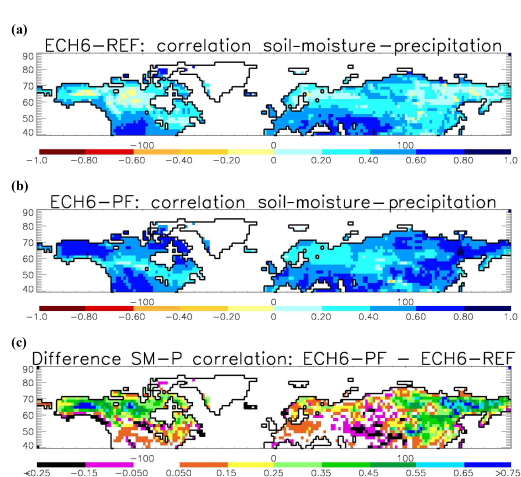
Figure 12. Correlation of soil moisture and precipitation for (a) ECH6-REF, (b) ECH6-PF, and (c) difference between ECH6- PF and ECH6-REF.